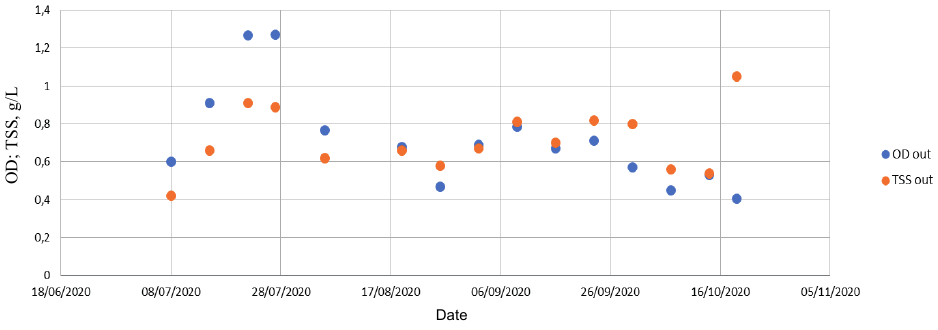
Fig. 2. Time course of microalgal density, expressed as TSS (g L −1 ) and optical density at 680 nm, during the experimental